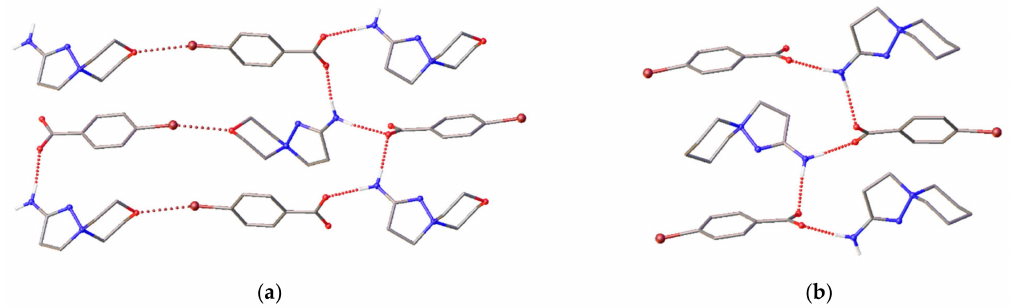
Figure 4. Fragment of H-bonded chains in the crystal of ( a ) 5d and ( b ) 2-amino-1,5-diazaspiro[4.5]dec-1-en-5-ium 4-bromobenzoate (deposit CCDC 1496456). Color code: Br—brown, C—grey, H—white, N—blue, O—red. The H(C) atoms are omitted. Intemolecular interactions are shown with dotted lines.